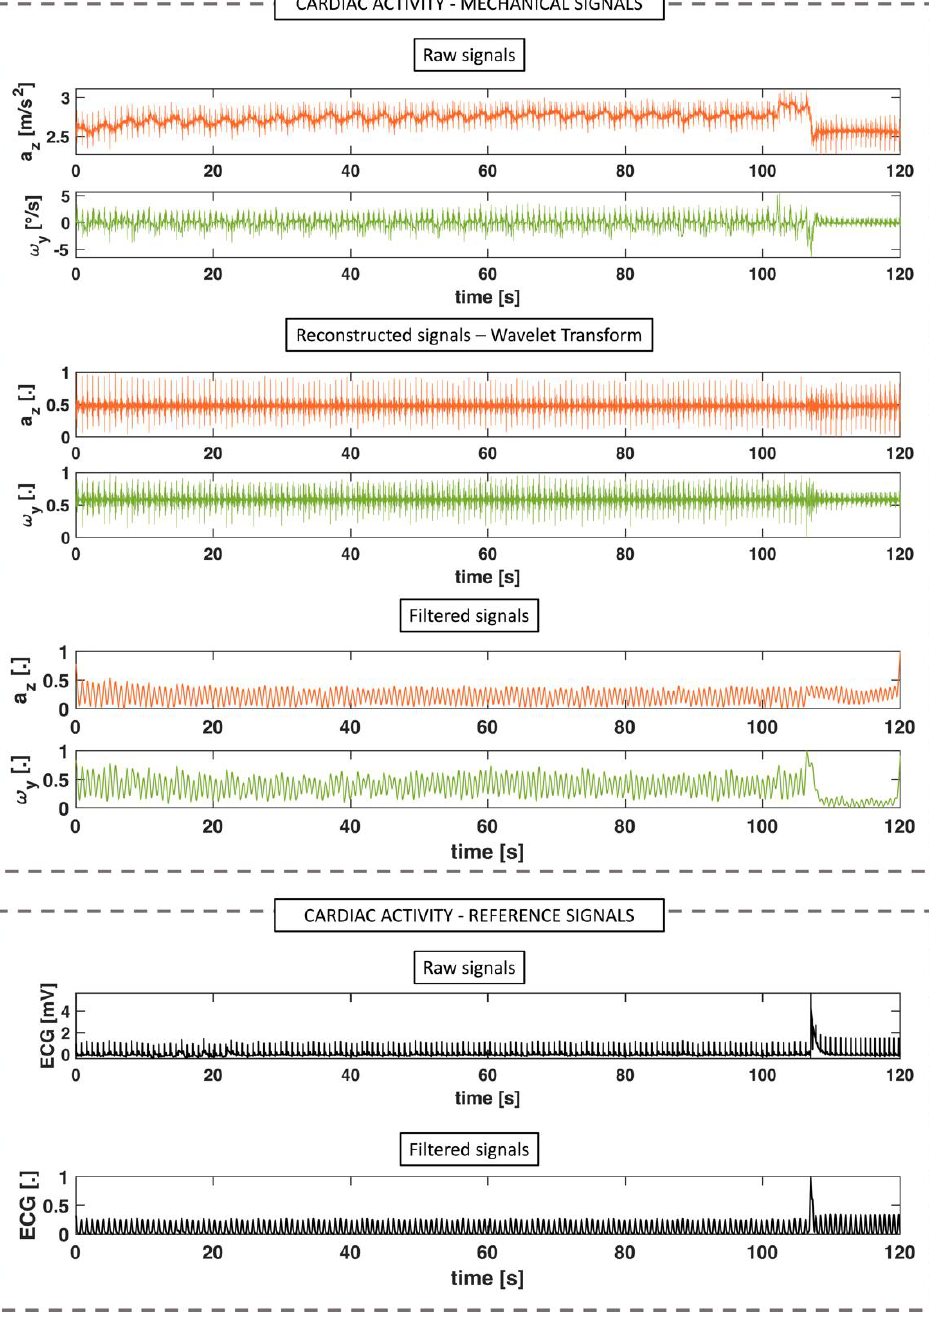
Figure 3. Signal processing for cardiac activity extraction for mechanical signals (i.e., accelerations, a and angular velocities, ω ) and reference signal (ECG). After acquiring the raw signals of the ACC and the GYR, only one axis was selected to reduce the dimensionality of the problem (i.e., the z axis for the ACC and the y axis for the GYR). The selected signals were reconstructed using the inverse wavelet transform by selecting frequencies between 10 Hz and 40 Hz and normalized. Finally, the normalized signal envelope was extracted to emphasize the heartbeats and filtered between 0.7 and 3 Hz. Concurrently, the raw ECG reference signal was filtered between 0.7 and 3